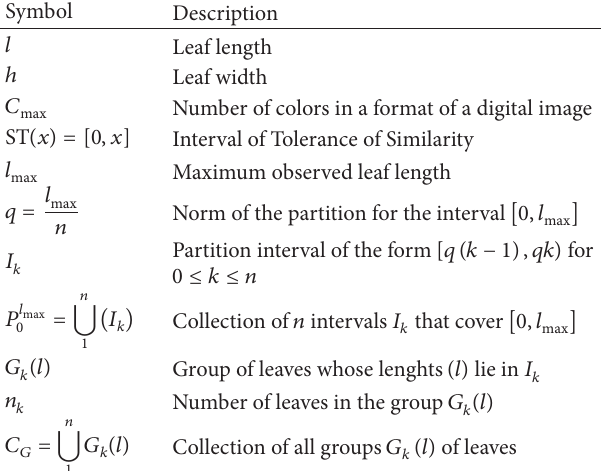
Table 1: Different symbols used in the digital image processing method.